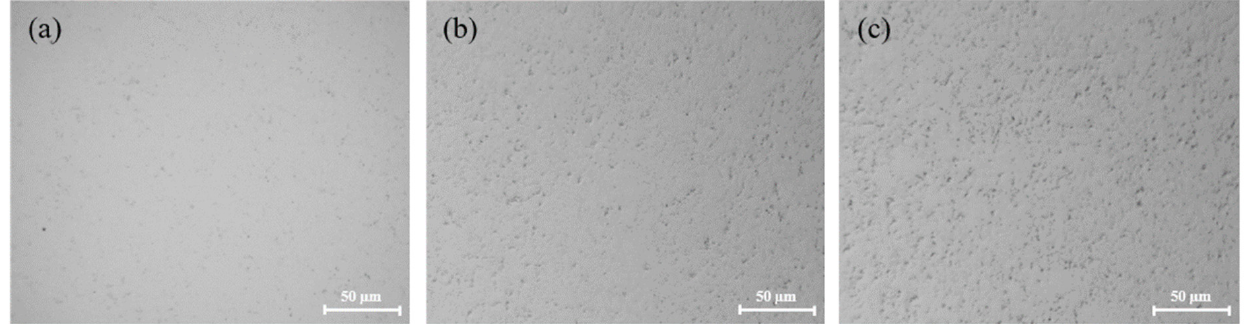
Figure 7. Surface morphologies of polished tungsten under different pH values: ( a ) pH = 9; ( b ) pH = 11; ( c ) pH = 12.